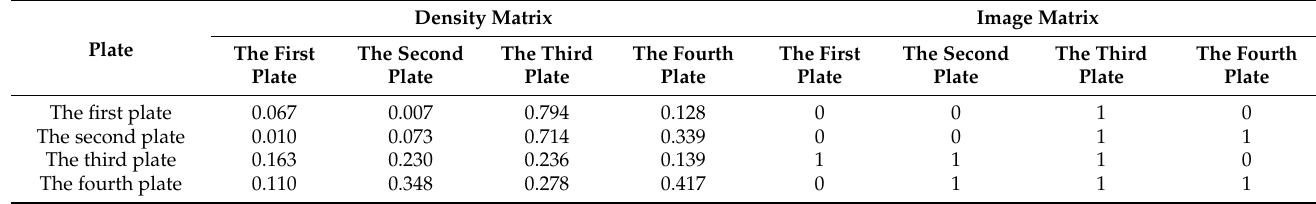
Table 4. Linkage effect analysis of the spatial correlation plates of the UECC in the YRB in 2017.